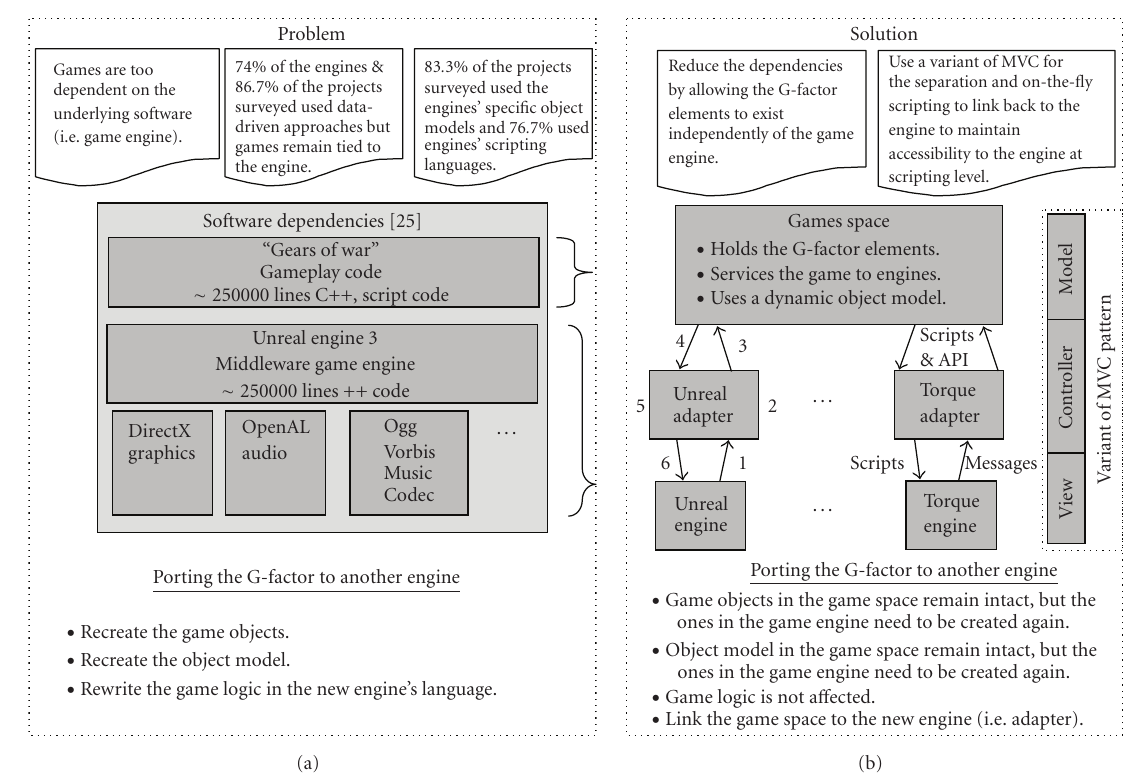
Figure 2: GSA overview. The numbers highlighting the communication between the game space and the game engine are described in Figure 3.